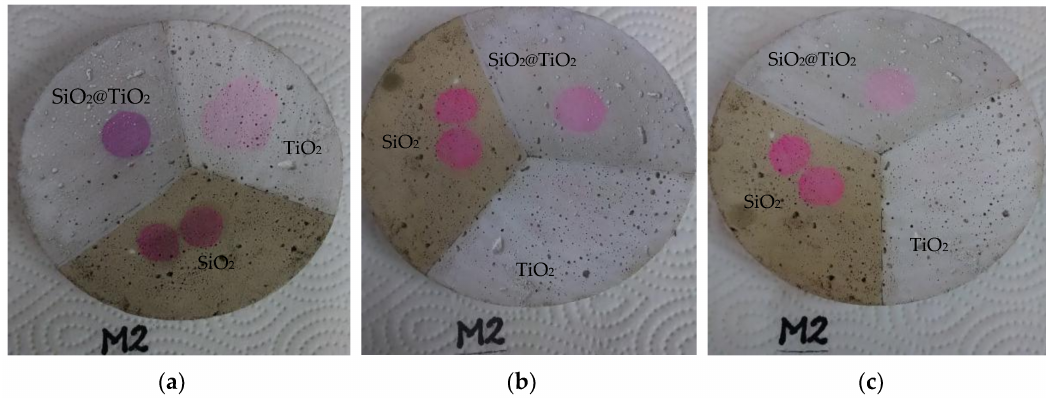
Figure 9. Comparison of the degradation of RhB, before and after UV-A irradiation. ( a ) 0 h; ( b ) 4 h; ( c ) 26